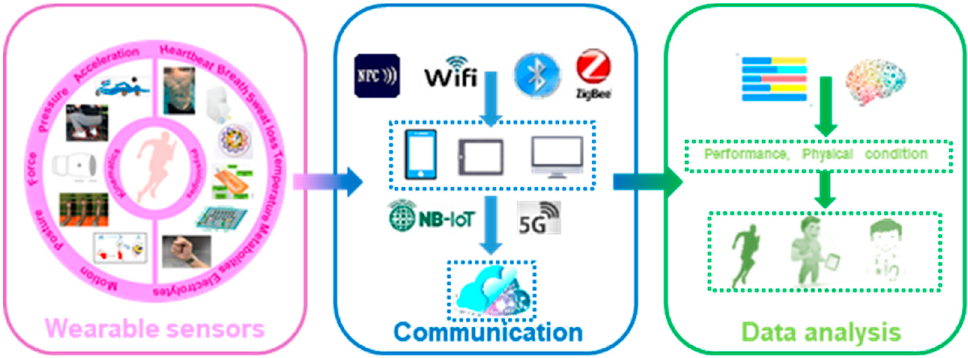
Figure 19. The capture, transmission and processing/analyzing of data in sports.